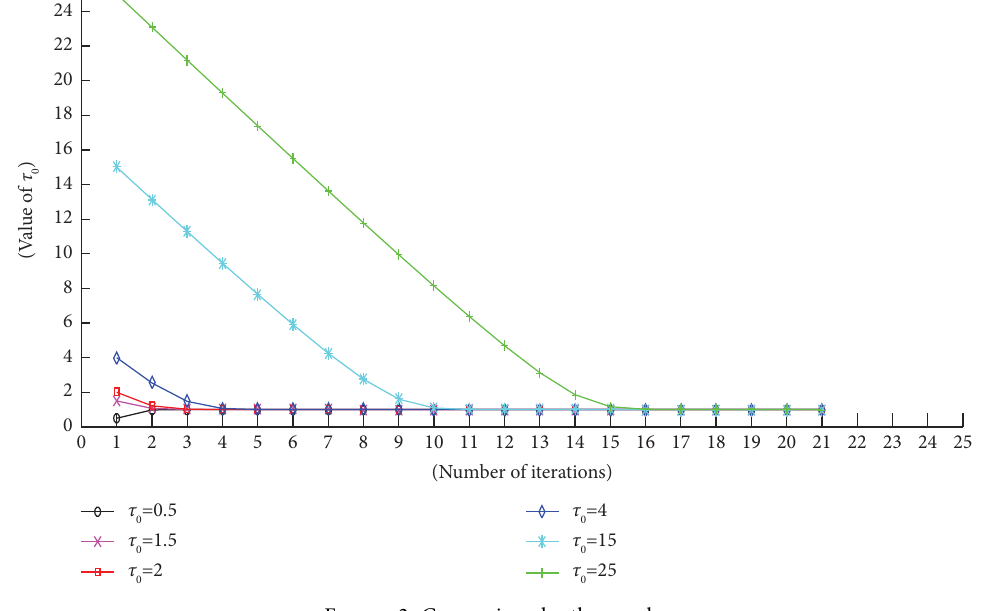
Figure 2: Comparison by the